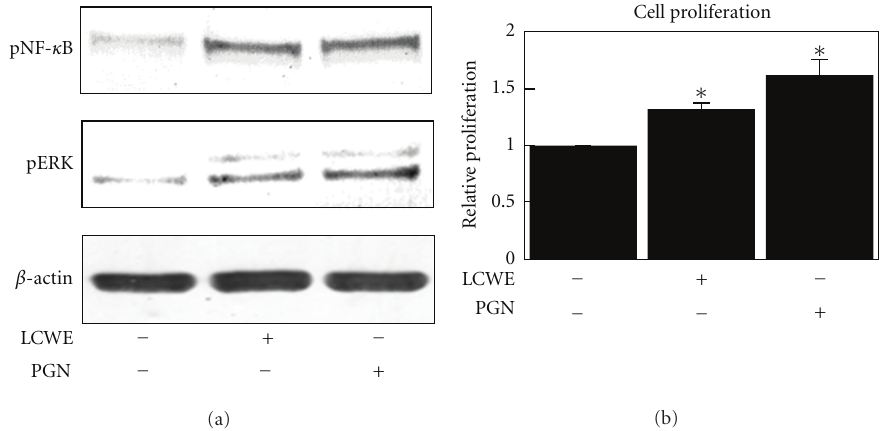
Figure 1: Changes in the levels of phospho-NF- κ B and phospho-ERK (a) and change in cell proliferation (b) in NIH3T3 mouse fibroblast cells after treatment with LCWE (10 μ g/mL) or PGN (10 μ g/mL). Each column represents the mean ± SEM. ∗ P < 0 . 01 versus untreated